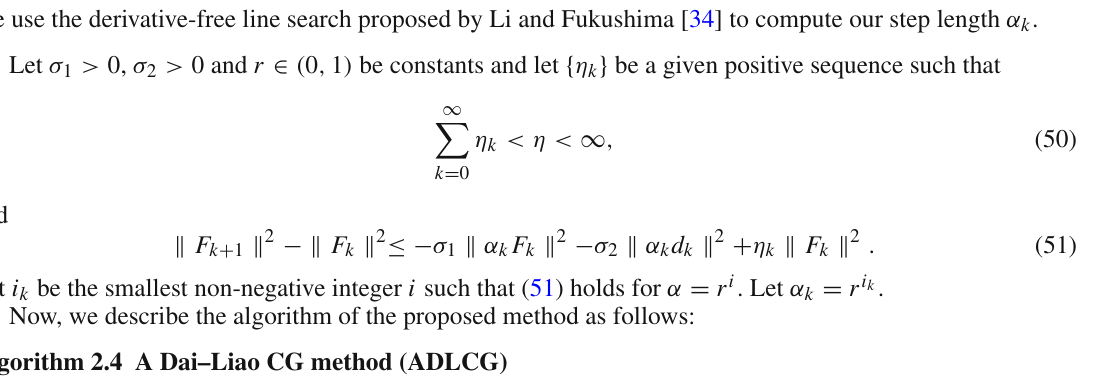
Algorithm 2.4 A Dai–Liao CG method